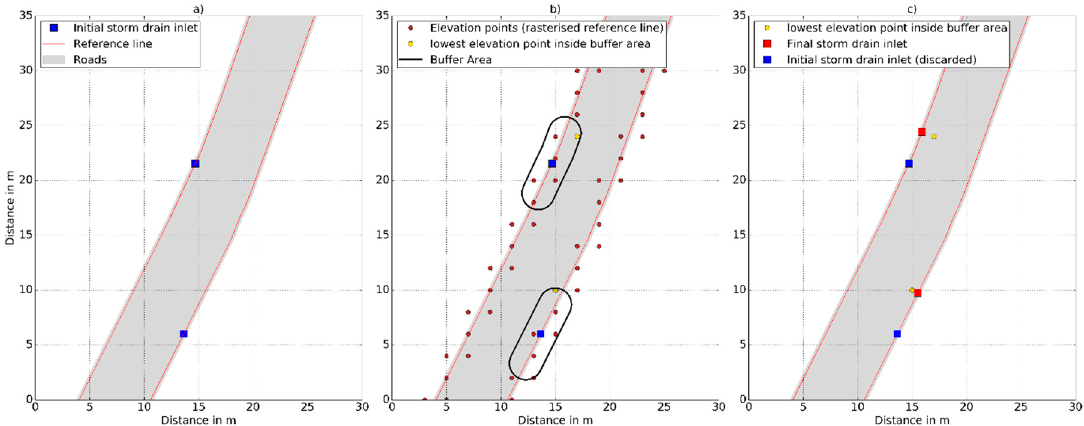
Figure 5. Re-distributing process of initial storm drain inlets ( a ) by applying terrain information to identify lower lying cells ( b ) and final, re-distributed inlet location with discarded, initial one ( c ). Based on the criteria outlined above an adjusted storm drain inlet can be at a maximum distance of 4.5 m to its initial one. The more important change between the initial and adjusted storm drain inlet, however, is the difference in their elevation. A comparison between the terrain elevation at the initial location and the adjusted one found an average drop in elevation of 6.9 cm (Figure 6). The maximum drop in elevation between an initial and adjusted inlet is 0.91 m. At that location, the elevation of the initial storm drain inlet was affected by an embankment feature close to the